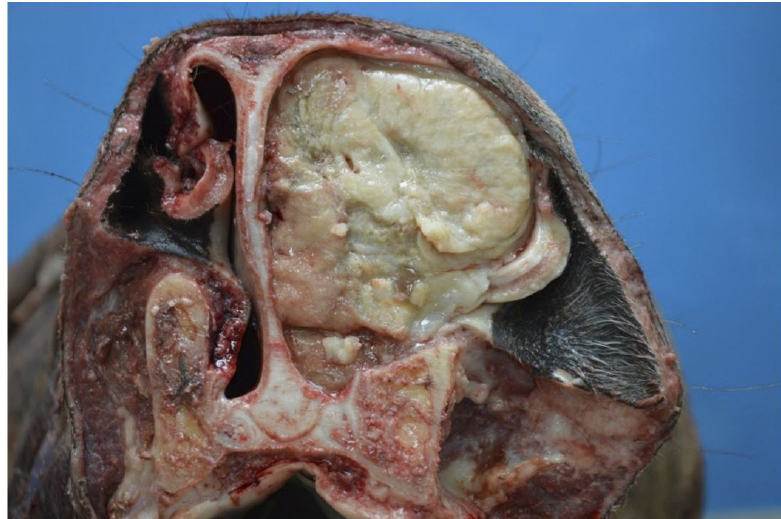
Figure 4. Rostral cross-sectional view of the bone and nasal cavity of the subject. A solid, white neoplasm, replacing the nasal turbinates, filling and obstructing the left nasal cavity, with displacement of the nasal septum to the right, is observed.